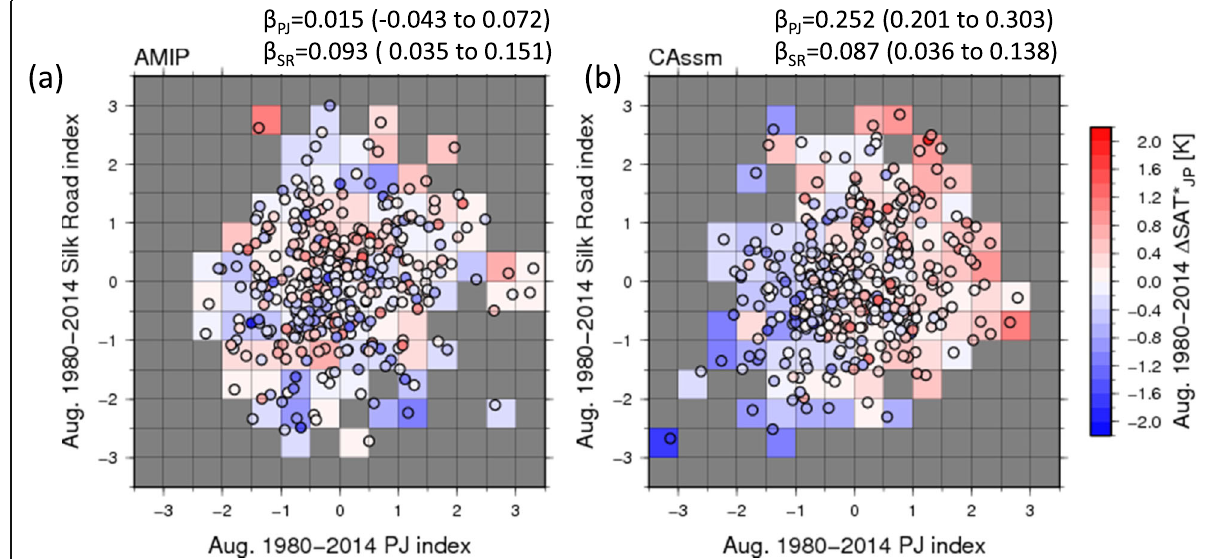
Fig. 5 Multiple linear regression of the detrended SAT JP anomalies against PJ and Silk Road pattern indices obtained from 350 year (10 members for 1980 to 2014) ensemble simulations using a AMIP and b CAssm experiments. Each circle shows the detrended SAT JP anomaly for each year, and the background tiles show the average of the detrended SAT JP anomalies within them. The gray tiles mean there are no circles within them. β β PJ and SR are the regression coefficients of PJ and Silk Road pattern indices with 95% confidence intervals as the numbers within parentheses,